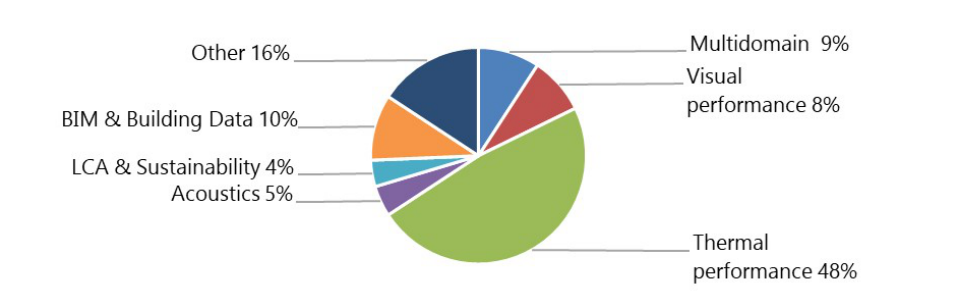
Figure 2. Topical distribution of the BST graduates’ master theses.